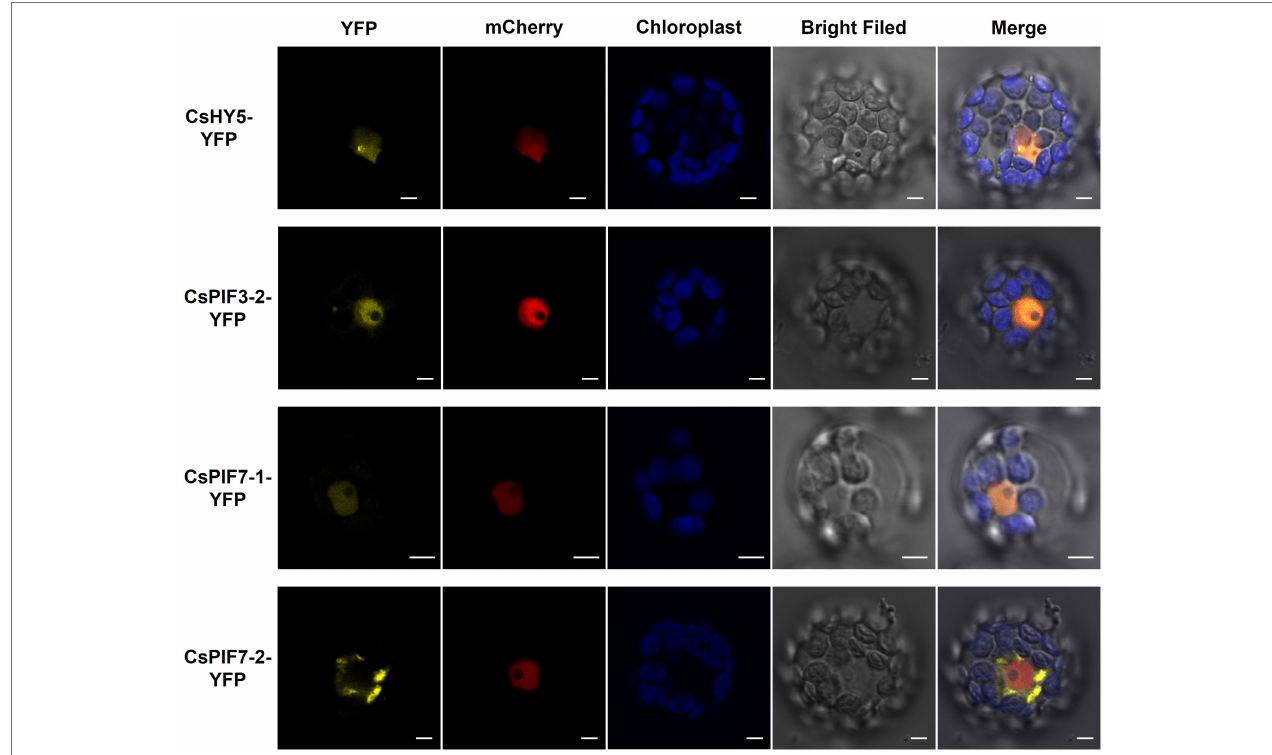
FIGURE 5 | Subcellular localization of CsPIF3/7 and CsHY5. The YFP fusion protein of CsPIF3/7 and CsHY5 was transiently expressed in Arabidopsis protoplasts. Yellow fluorescence represented YFP fusion protein of CsPIF3/7 and CsHY5. Red fluorescence represented mCherry protein marker for cell nucleus. Blue fluorescence was the chlorophyll autofluorescence. CsHY5-YFP, CsPIF3-2-YFP, and CsPIF7-1-YFP fusion protein were visible in nucleoplasm structures in the Arabidopsis leaf cell. CsPIF7-2-YFP fusion protein may be not in nucleoplasm structures. Bar = 5 μ